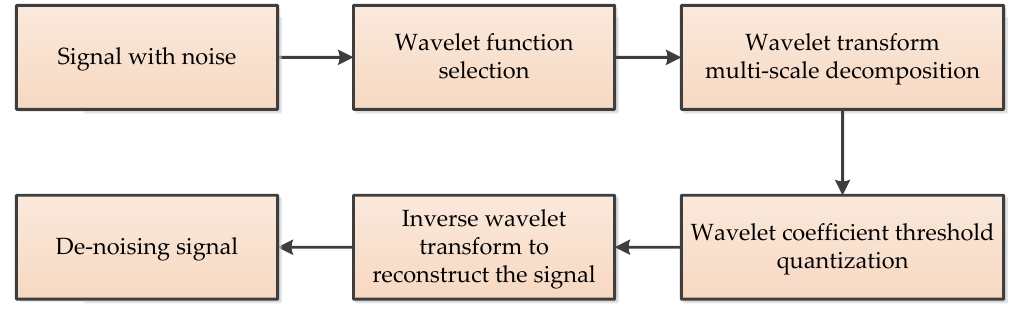
Figure 8. The denoising process of the wavelet threshold.